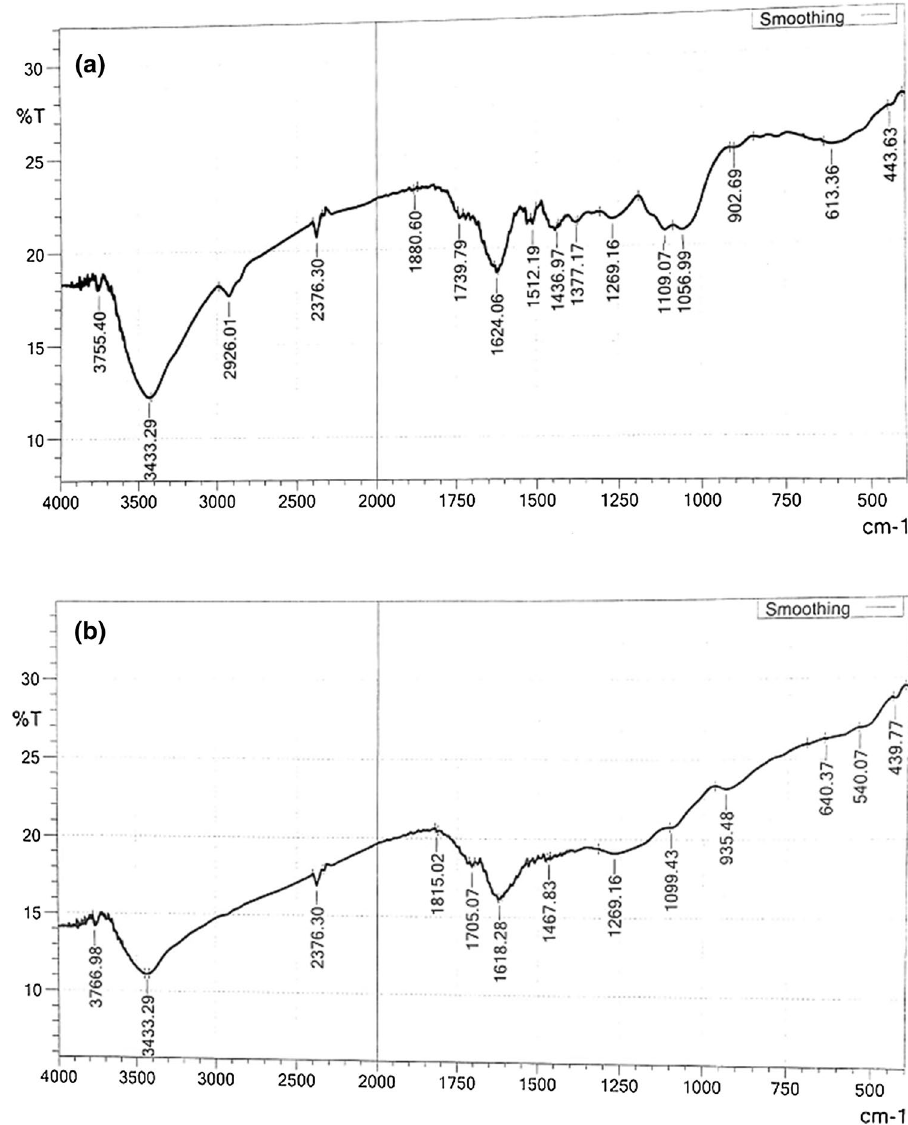
Fig. 1 FTIR spectra of a raw coconut husk (RCH) and b acti- vated coconut husk